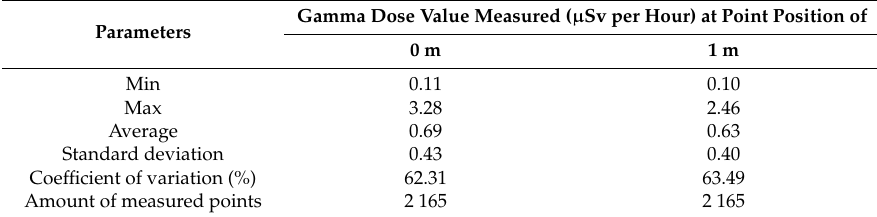
Table 2. Statistic of gamma dose characterization.